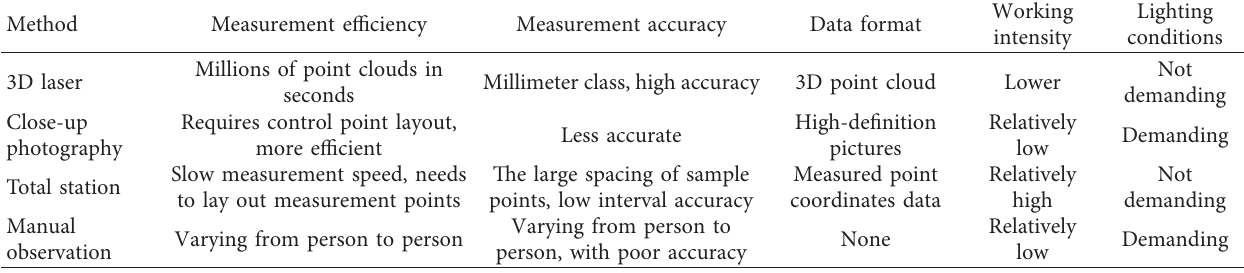
Table 1: Comparison of 3D laser and conventional measurement methods.